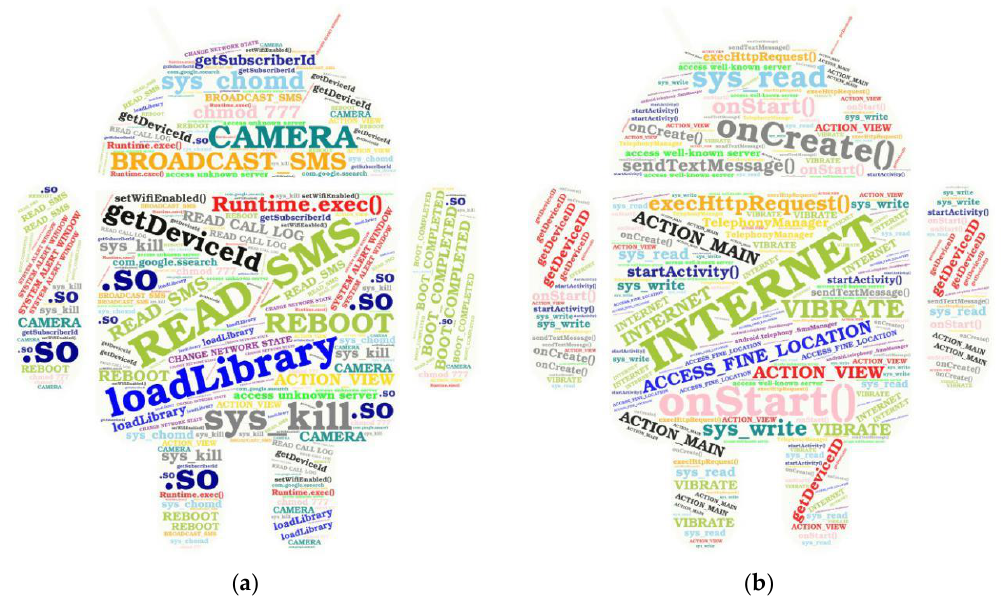
Figure 9. Visualization comparison of behavioral portrait between Android benign app and malware. ( a ) Behavioral portrait of Android malware; ( b ) behavioral portrait of Android benign app.